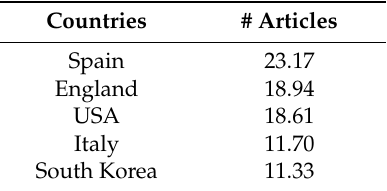
Table 5. Top countries (author filiation).